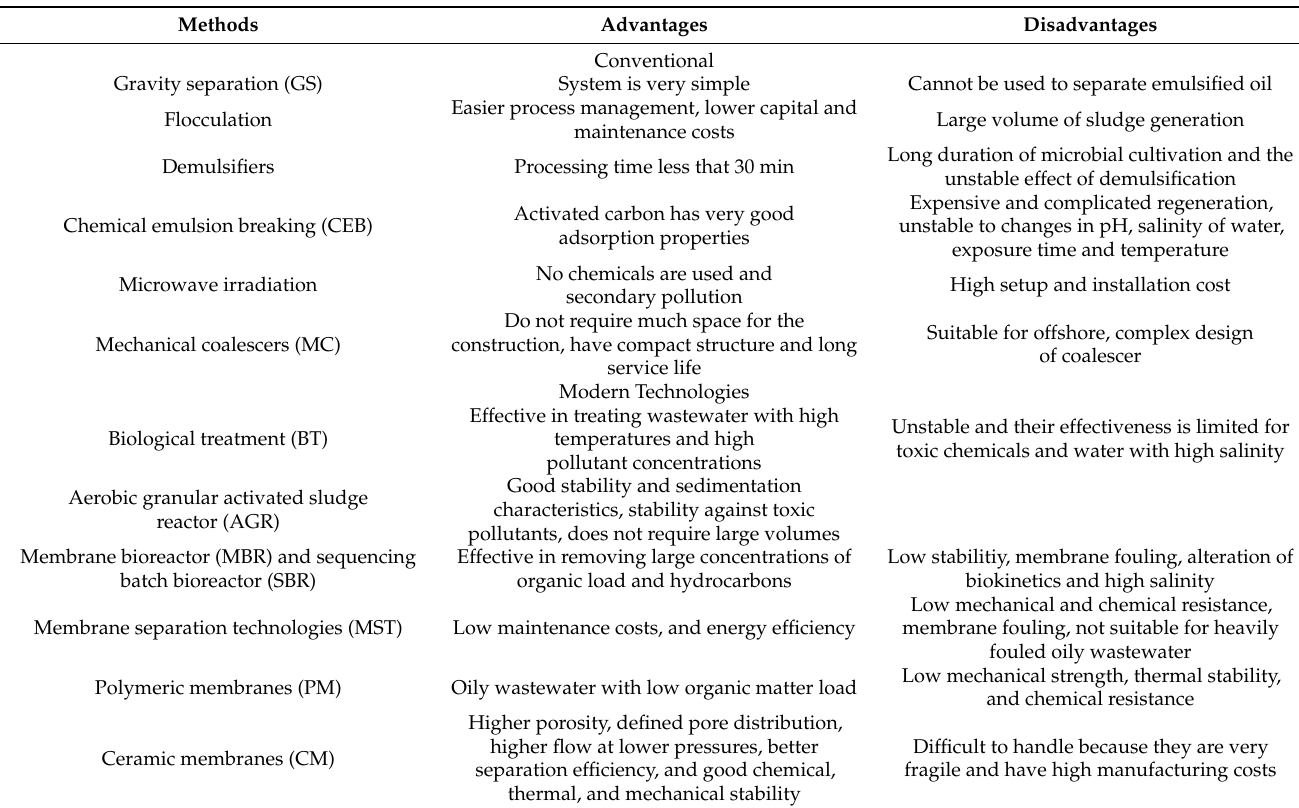
Table 1. Advantages and disadvantages of conventional methods and modern technologies for the treatment of oily